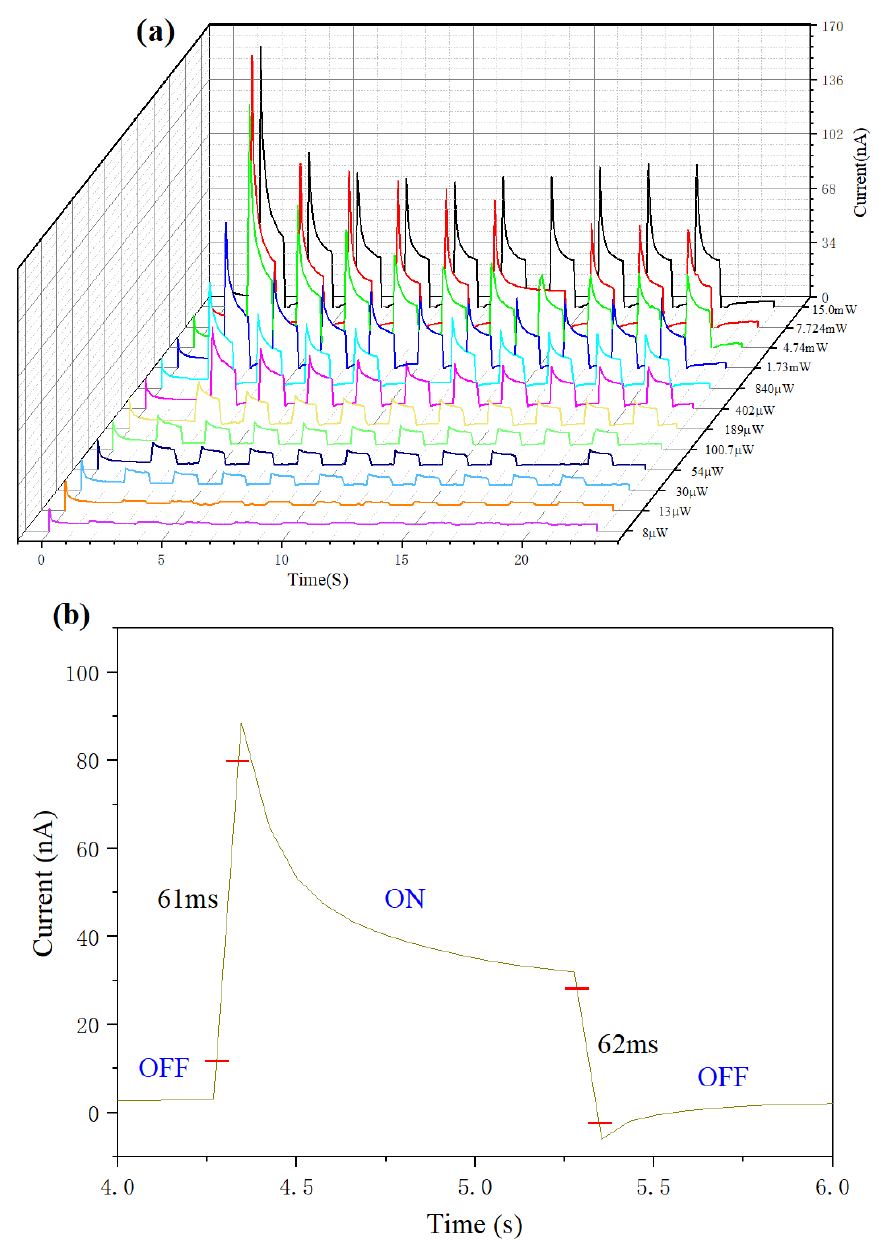
Figure 3. ( a ) Photoresponse characteristics under zero-bias 375 nm laser. ( b ) Response time of HDA-BiI 5 -based photoelec- tronic devices at the wavelength of 375 nm and a power of 4.74